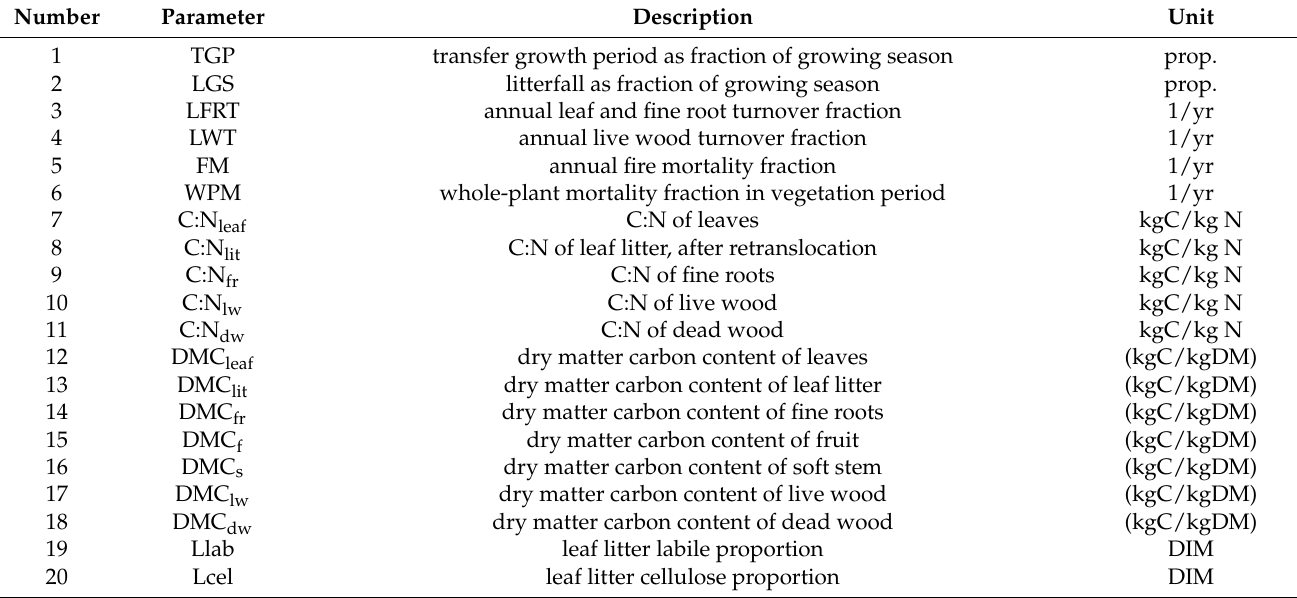
Table 1. Selected input parameters of Biome-BGCMuSo used in the sensitivity